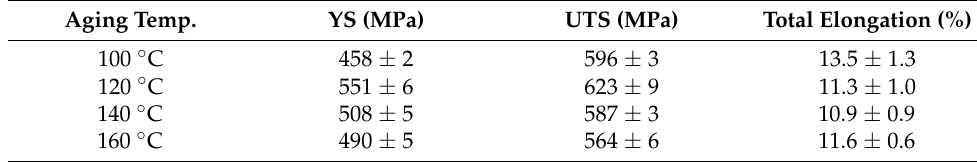
Table 3. Mechanical properties of 7075-HCu subjected to different PA treatments. Aging